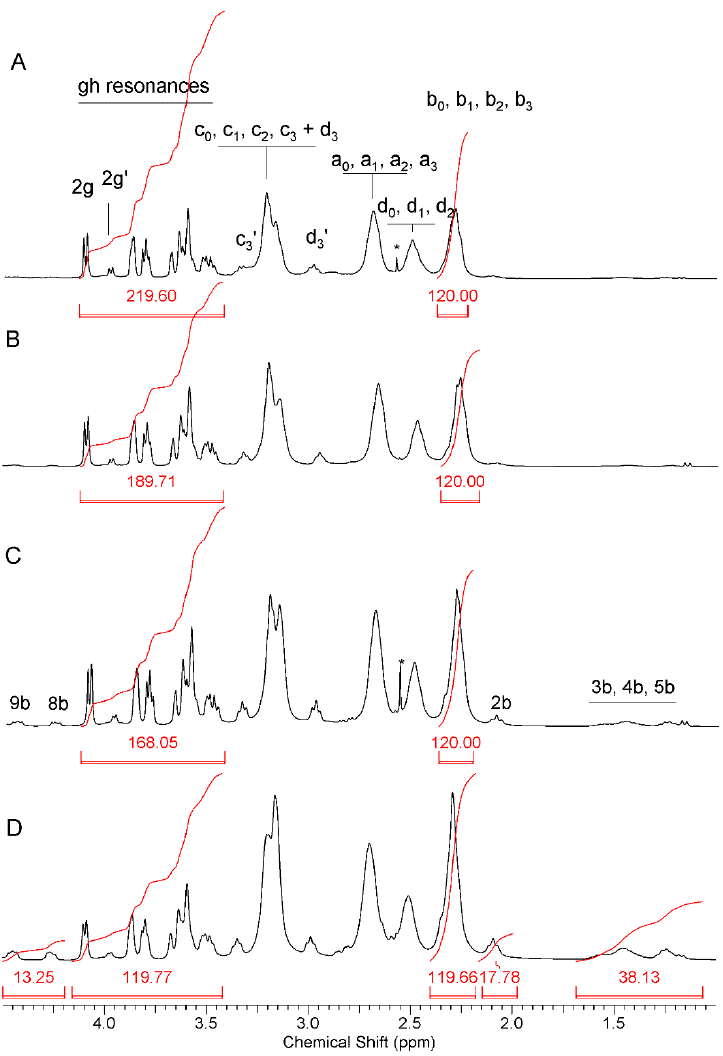
Figure 1. The 1 H NMR spectra of G3 1B31gh ( A ), G3 2B27gh ( B ), G3 4B24gh ( C ), and G3 8B17gh ( D ) in deuterium oxide. The broad signal for all CH 2 (b) resonances of the PAMAM G3 core was used as internal intensity reference [120H]. The residual DMSO resonance is labeled with asterisk.